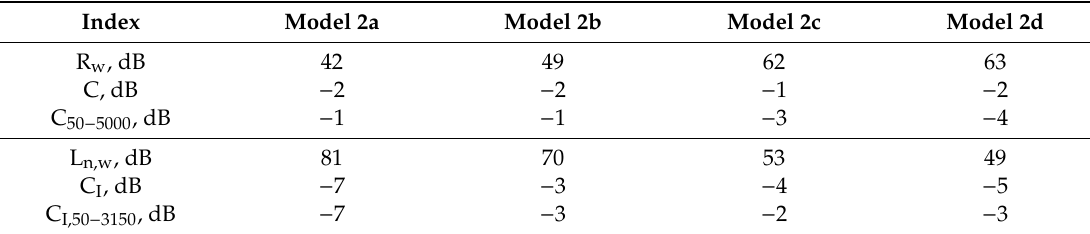
Table 6. Single-number quantities of a metal frame floor.